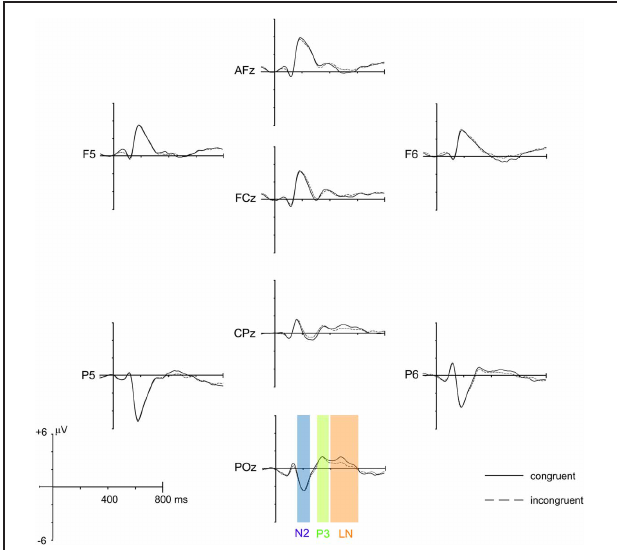
FIGURE 2 | Grand mean average ERPs of all 28 participants for congruent and incongruent stimuli, averaged over Group (meditation, control) and Time (T1, T2, T3). ERPs from eight representative electrodes (out of 64scalp electrodes) are shown. The three analysis time windows (N2: 160–240ms, P3: 310–380ms, and LN: 400–600 ms) are indicated at electrode